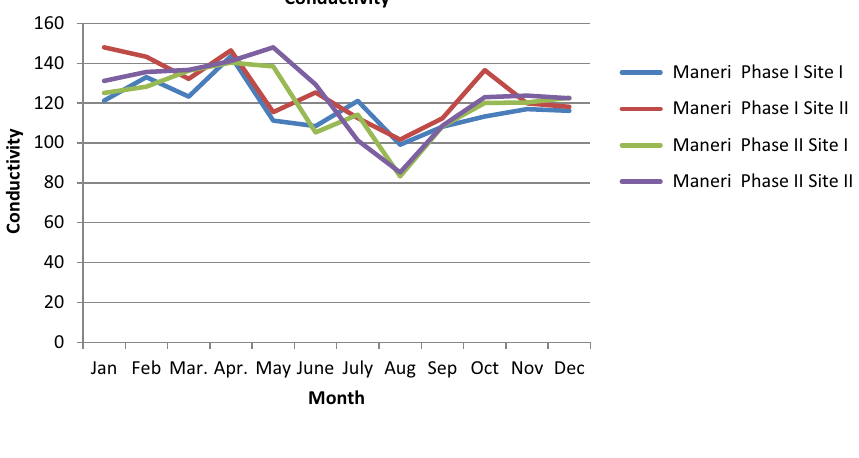
Fig. 9 Monthly recorded Con- ductivity (µ S cm −1 ) of